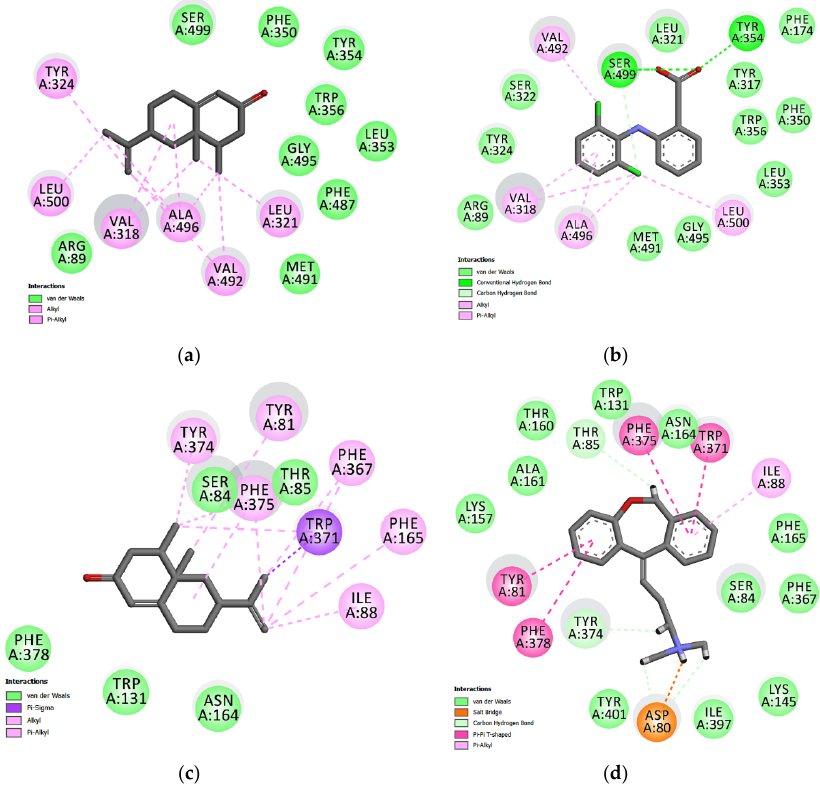
Figure 7. Maps of amino acid residues within the binding pocket of COX-2 ( a and b ) and the H1 receptor ( c and d ). The interactions of NKT ( a and c ), Diclofenac ( b ), and Doxepin ( d ) with these amino acids is illustrated.